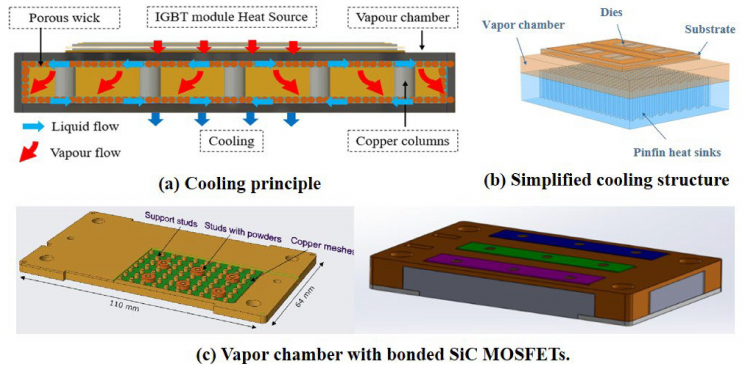
Figure 12. Schematic of the vapor chamber with bonded substrates